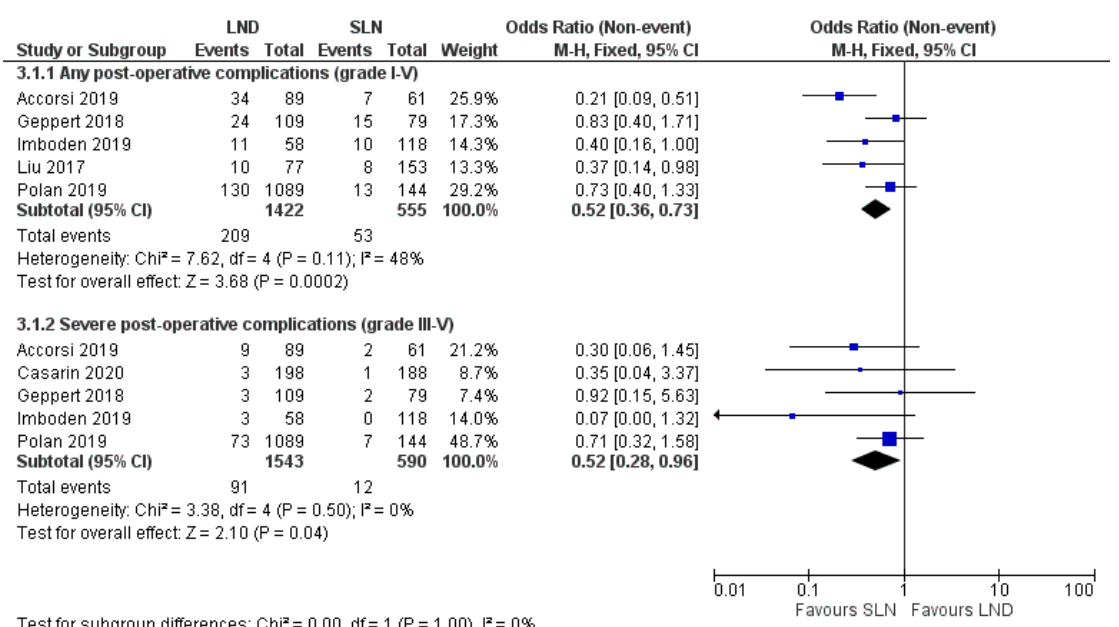
Figure 2. Forest plot on any (3.1.1) and severe post-operative complications (3.1.2) after SLN versus LND. Grading is based on the Clavien Dindo Classification. Abbreviations : SLN sentinel lymph node biopsy, LND lymph node dissection. p < 0.05.